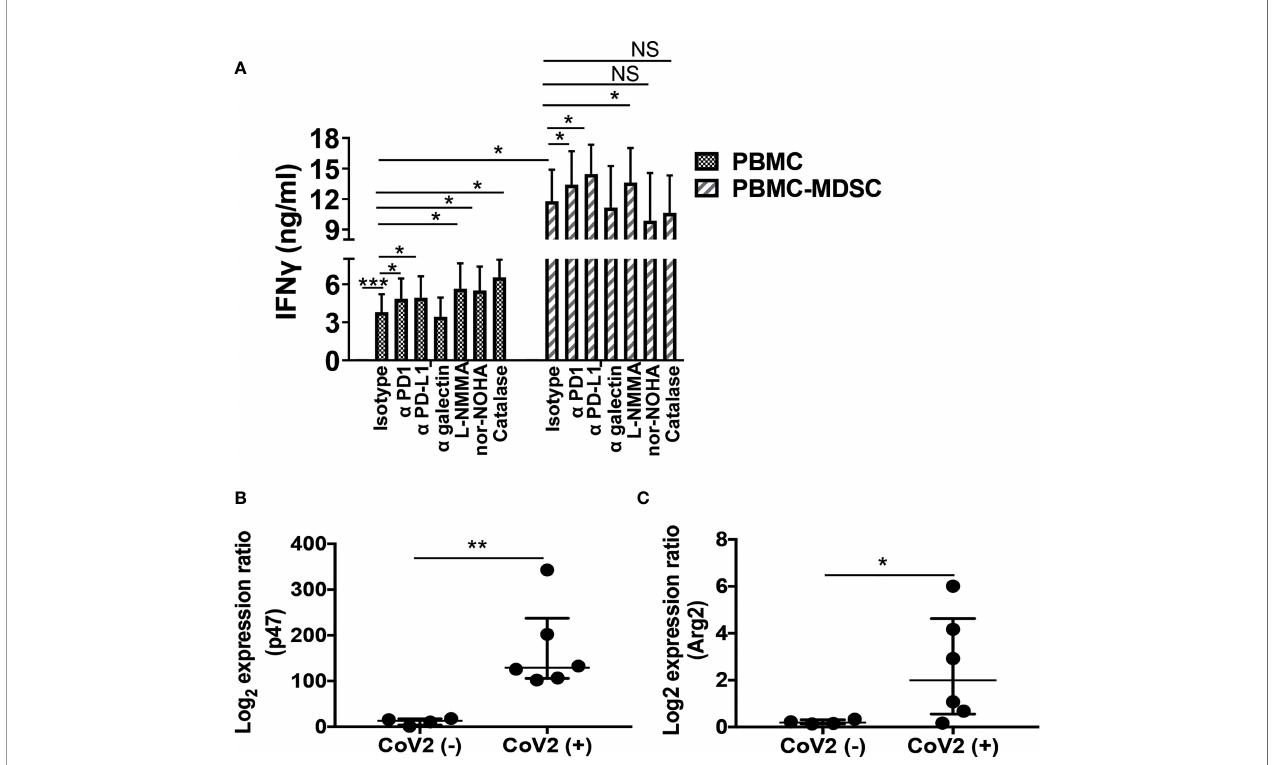
FIGURE 5 | M-MDSC mediated T cell inhibition is dependent on Arg and ROS: Freshly isolated PBMC from CoV2- and CoV2+ individuals were stained with anti- CD14 and -HLA DR antibodies; CD14 + HLA DR -/lo M-MDSC were depleted from PBMC by fl ow cytometry. (A) Whole PBMC (PBMC) and MDSC depleted PBMC (PBMC-MDSC) of CoV2+ individuals were cultured in the absence or presence of the peptide pool of S-antigen in presence of blocking anti-PD1, -PD-L1, -galectin antibodies or isotype-matched control antibody, or in presence of iNOS inhibitor (L-NMMA), arginase inhibitor (nor-NOHA) or ROS inhibitor (Catalase). Supernatants were collected at 48-72 hours and the quantity of IFN g was measured by ELISA. (B, C) RNA was isolated from sorted CD14 + HLA DR -/lo MDSC using Trizol. The expression of (B) p47 phox (p47) and (C) Arg2 was determined by qRT PCR as detailed in Methods . For (A) Mean values +/- SEM are shown from 4 separate donors; (B, C) each dot in the plots depicts data of each individual donor, the plots include observations from 25 th to 75 th percentile. The horizontal line represents the median value. *p < 0.05, **p < 0.005; ***p < 0.0005; NS, Non-signi fi